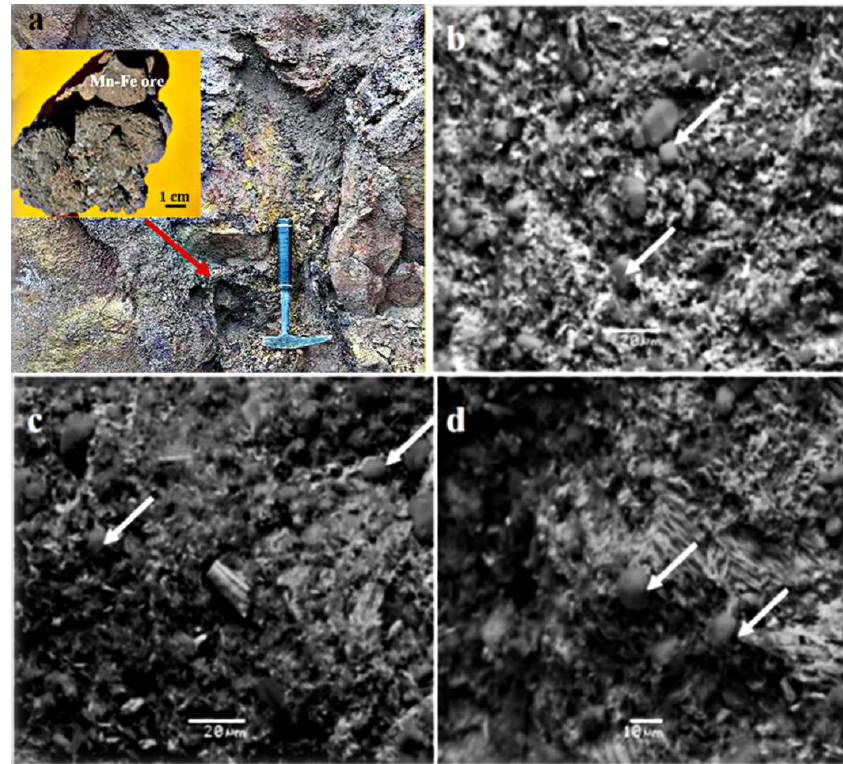
Figure 7. ( a ) Photograph of botryoidal Mn-Fe ore sample from Vani area, Milos Island. Back scat- tered scanning electron microscope images showing ( b – d ): bacteria fossils (white arrows) including abundant sphere or coccus within a matrix of hollandite, pyrolusite, hematite, and barite (see Table 1). Table 2. Representative bulk analyses of iron-manganese mineralizations from the Aegean